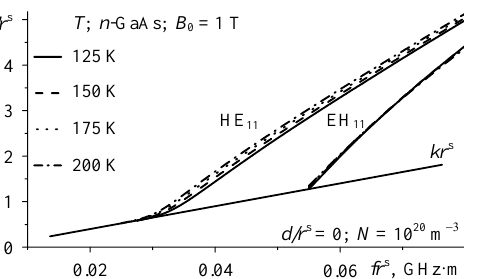
Fig. 8. Wave phase characteristics of models of gyroelectric n -GaAs semiconductor waveguides, when d/r s = 0; B 0 = 1 T; N = 10 20 m –3 .